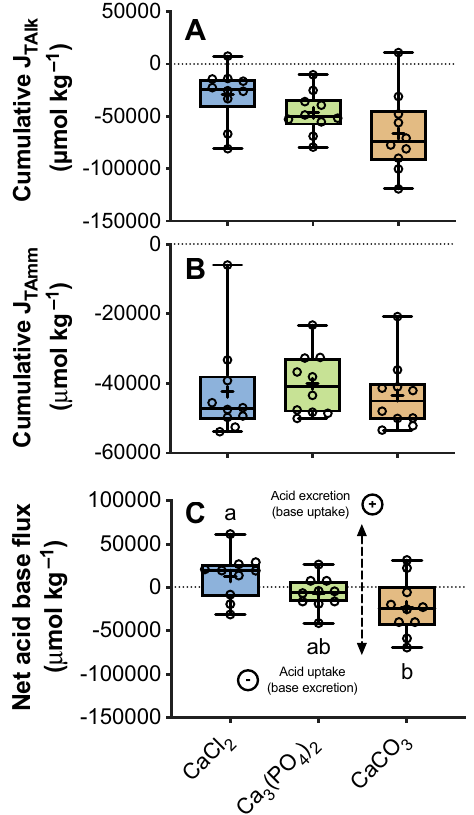
Figure 4. Average cumulative flux of titratable alkalinity (J TAlk ) ( A ), ammonia (J TAmm ) ( B ) and net acid or base ( C ) in juvenile rainbow trout ( Oncorhynchus mykiss ) fed a 2.5% ration of one of three experimental feeds supplemented with either Ca 3 (PO 4 ) 2 , CaCO 3 or CaCl 2 (n = 10 fish). For all fluxes, positive values indicate a net base uptake (i.e. acid excretion) and negative values indicate net base excretion (i.e. acid uptake) (See panel C). Data are presented as a six number summary: minimum, first quartile (Q1), median (horizontal line), mean (+), third quartile (Q3) and the maximum. Open circles represent values from individuals. Different letters (abc) indicate statistical significance between groups following a RM one-way ANOVA and Tukey’s multiple comparisons test. Significance was accepted at P <